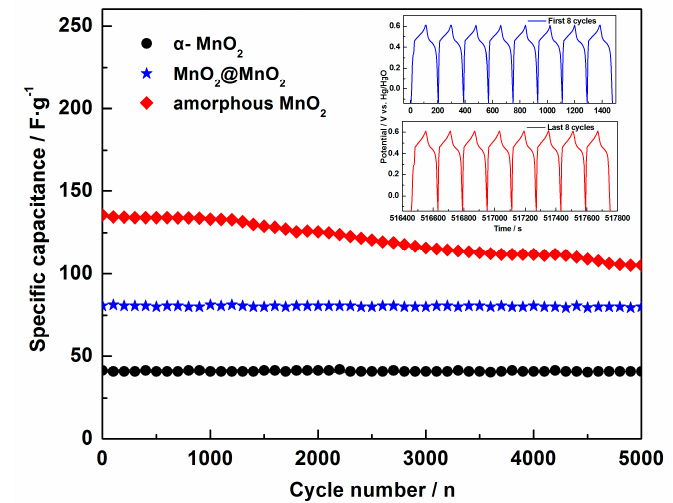
Figure 7. Cyclic stability of the three electrodes in a 1 mol·L − 1 LiOH electrolyte measured using the galvanostatic charge-discharge technique at a current density of 2 A·g − 1